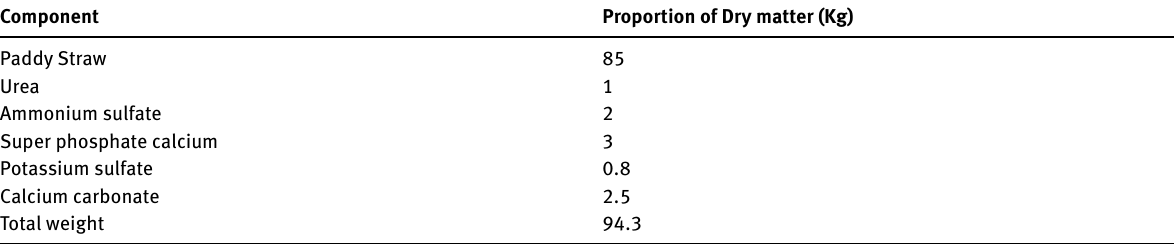
Table 2: Modified Straw Compost in Taiwan (Chang and Miles 2004) Component